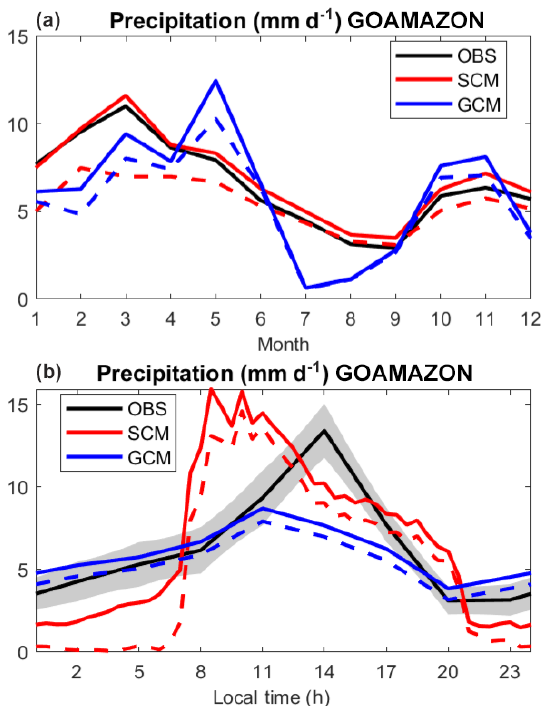
Figure 2. Precipitation from the GOAMAZON field campaign for SCM (red curve) and observations (black curve). The GCM results (blue curve) are taken from an E3SM run in the column closest to the GOAMAZON location (3 ◦ S and 300 ◦ E) from January through December of 2014. Panel (a) represents the annual cycle of pre- cipitation, while panel (b) represents the daily cycle. Solid curves represent the total precipitation rate, while dotted curves represent the contribution of the convective